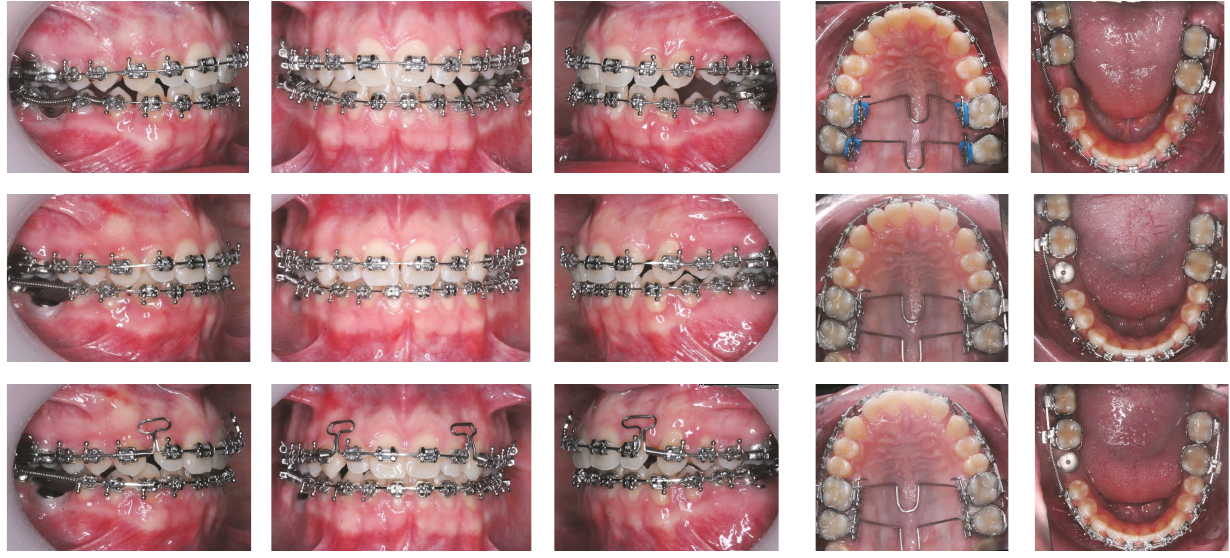
Figure 3: Intraoral treatment progress